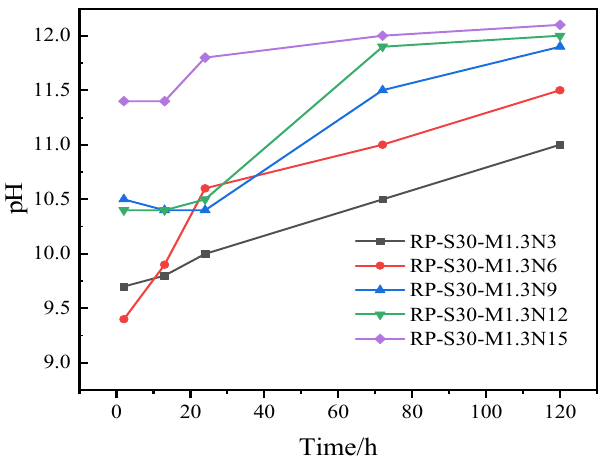
Figure 14. PH values of RPSG with different slag contents.